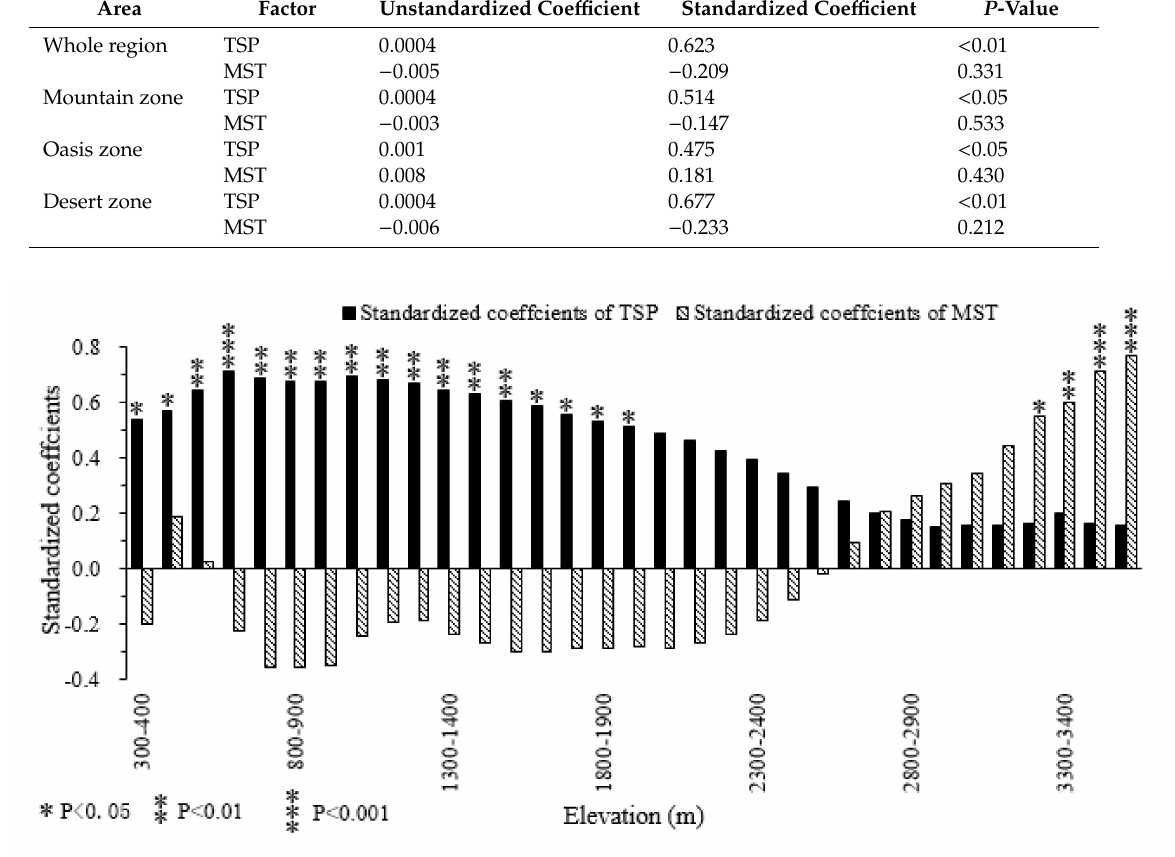
Figure 5. Standardized regression coe ffi cients between NDVI and total summer precipitation (TSP), mean summer temperature (MST) at each elevation